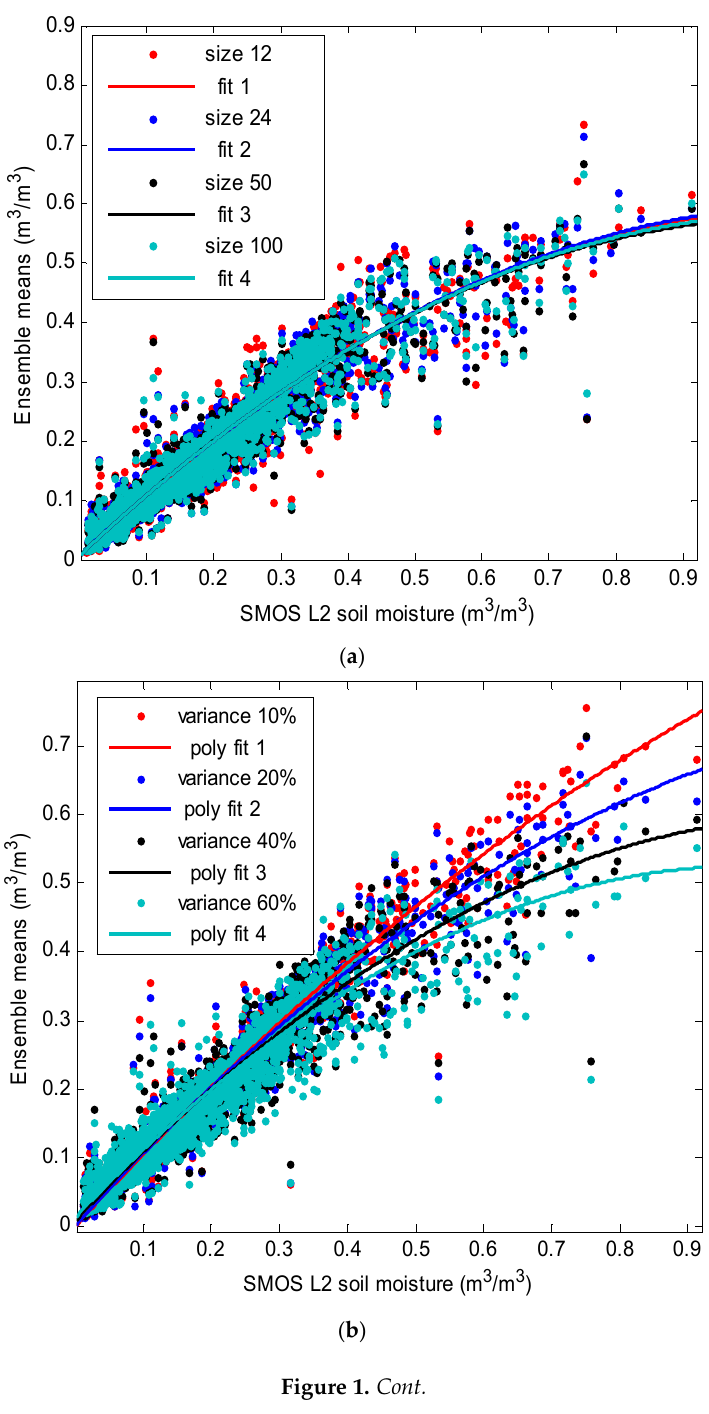
Figure 1. Cont. Figure 1.